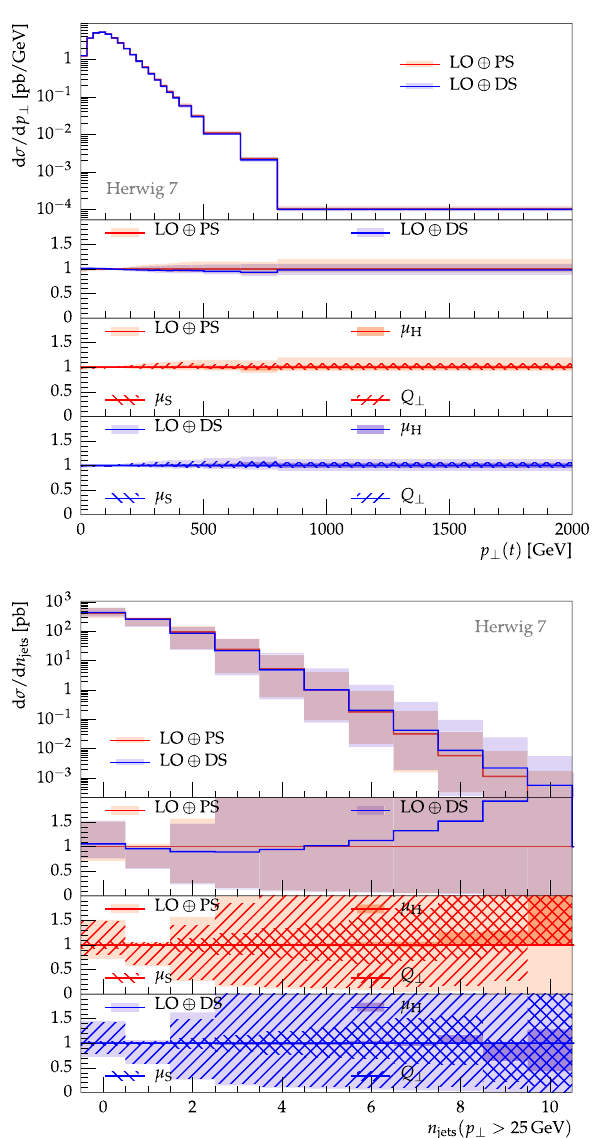
Fig. 6 Scale variations for the inclusive top p ⊥ -spectrum, the top pair transverse momentum spectrum, inclusive jet multiplicities and R dis- tance between the top pair and the hardest jet using LO plus (LO ⊕ ) parton shower simulations at 13 TeV. In each plot the upper ratio plot compares the envelopes of all variations for the angular-ordered (PS) and dipole (DS) showers, with a ratio to the central prediction of the